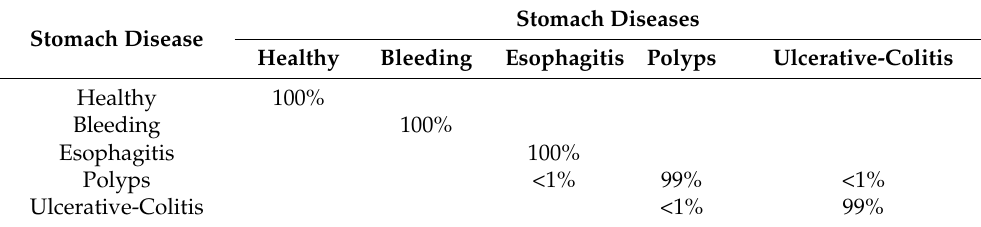
Table 4. Confusion matrix of proposed features optimization for stomach disease classification. Stomach Disease